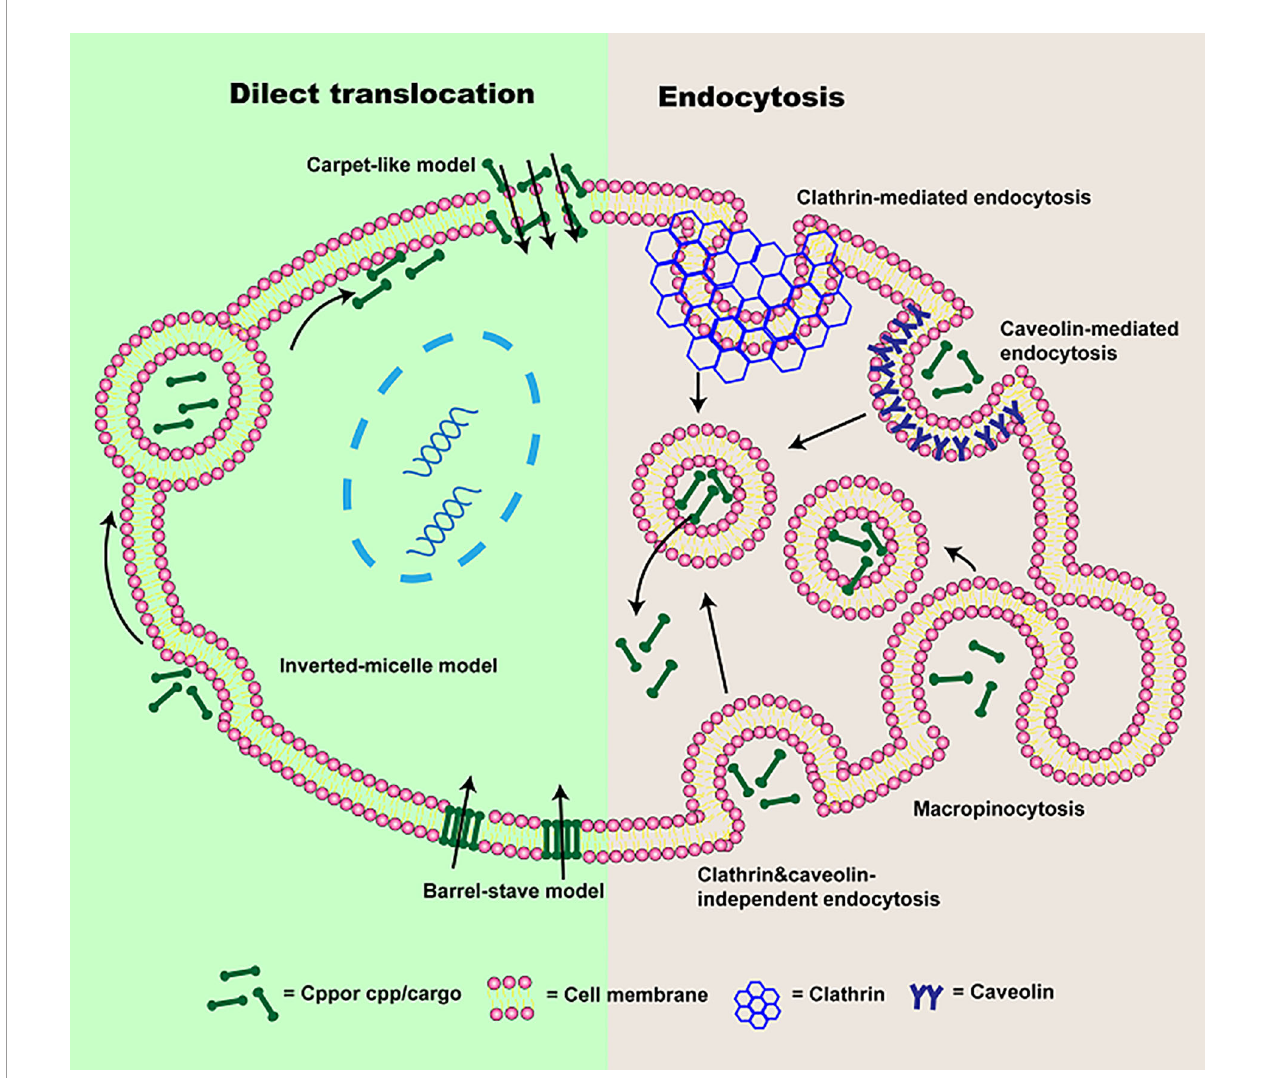
FIGURE 2 | The schematic of cellular uptake mechanisms of CPP or CPP/cargo. Two types of pathways were presented: direct translocation and endocytosis. Direct translocation is divided into three models: “ Barrel-Stave ” model, “ Carpet-like ” model, and the Inverted-micelle model. Endocytosis is composed of macropinocytosis, caveolin-mediated endocytosis, clathrin-mediated endocytosis, and clathrin- and caveolin-independent